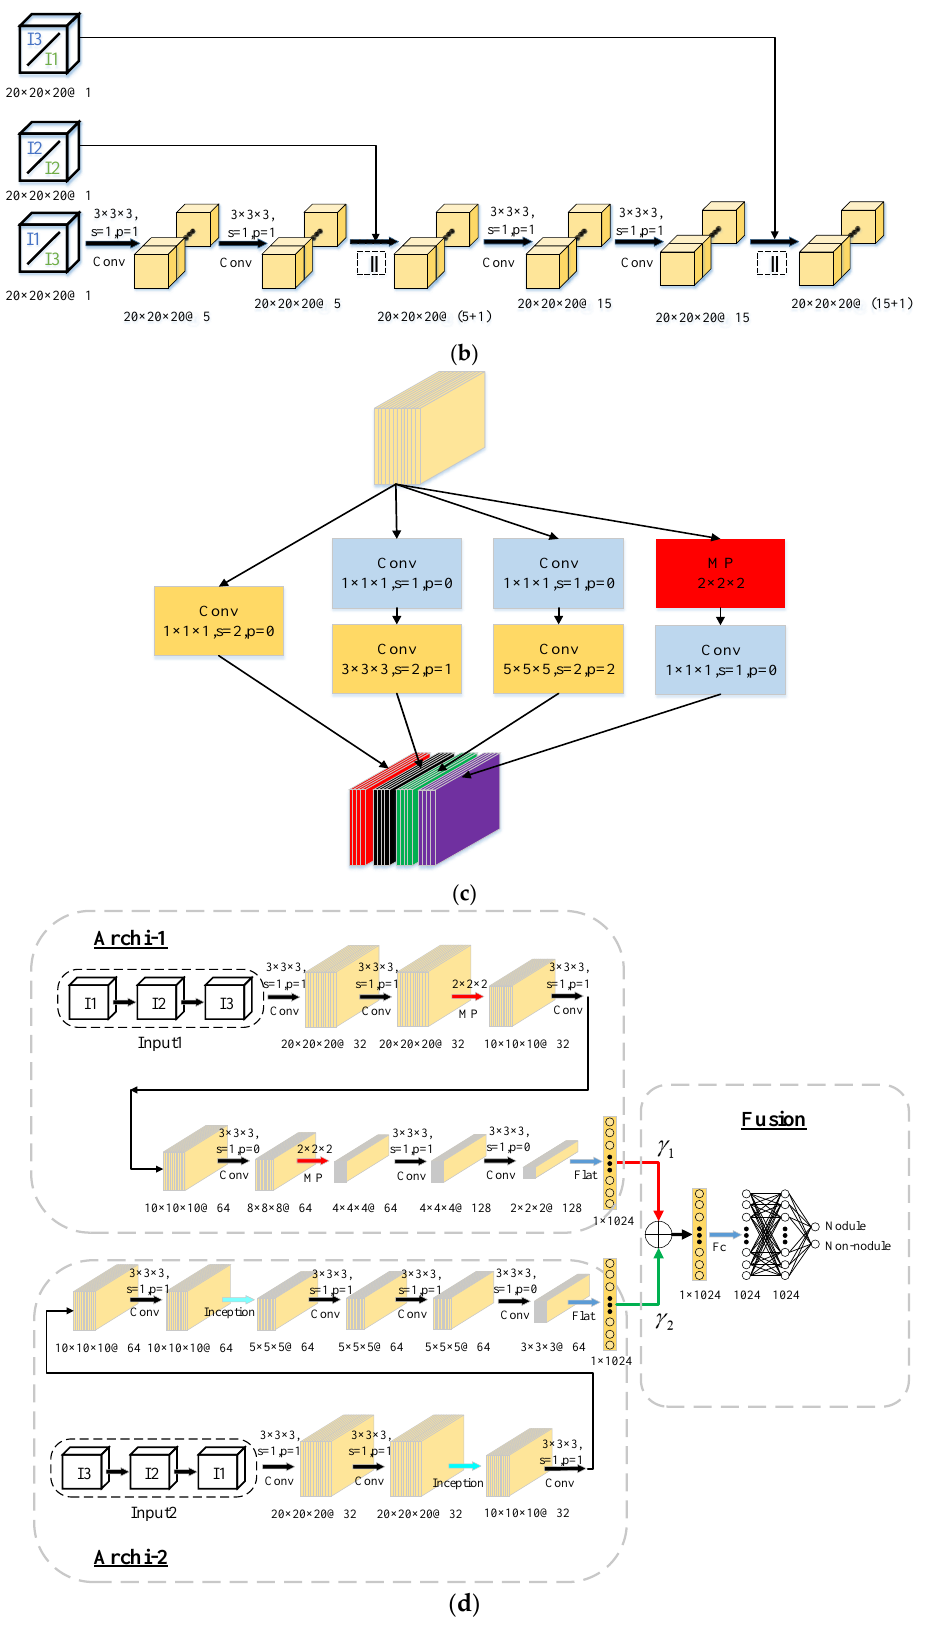
Figure 2. Our proposed pulmonary nodule false-positive reduction network framework. The numbers above the thick arrows present a kernel size, e.g., 3 × 3 × 3 . (s: stride, p: padding, Conv: three-dimensional (3D) convolution, MP: 3D max-pooling). The figure after @ denotes the number of channels. ( a ) Extraction of 3D nodule blocks. According to the coordinate parameters of each